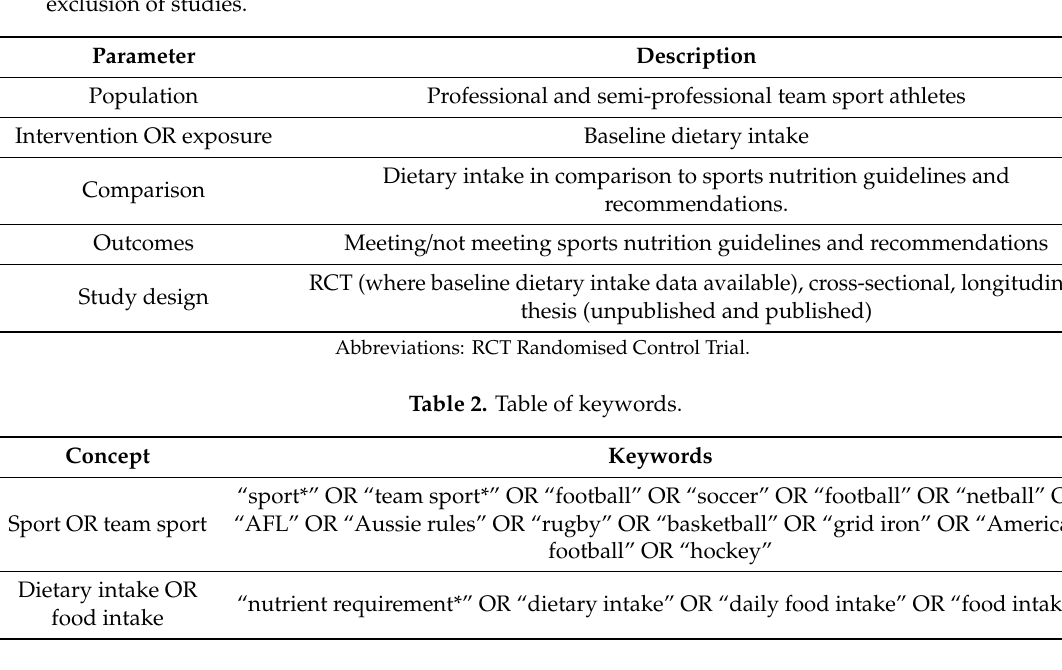
Table 1. Participants, Intervention, Comparison, Outcome and Study (PICOS) criteria for inclusion and exclusion of studies.